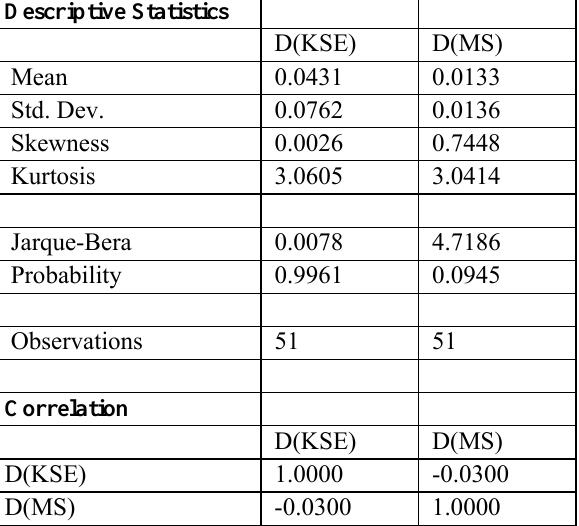
Table 1: Stock Index and Money Supply